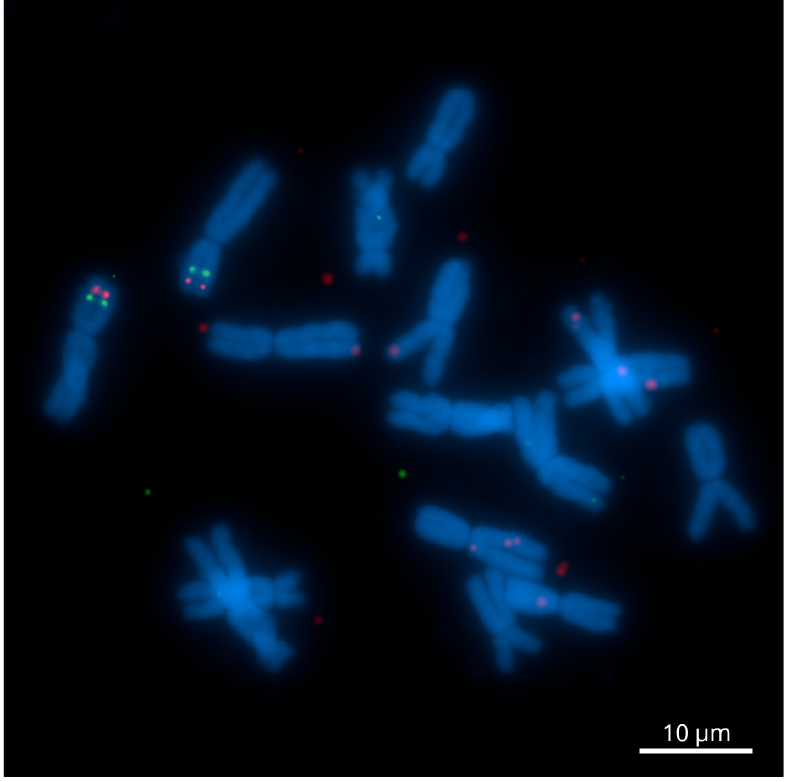
Figure 1. Dual-color Tyr-FISH on mitotic metaphase chromosome 2 of Allium cepa probing with Unigene23526 (red) and Unigene28076 (green). Scale bar—10 µ